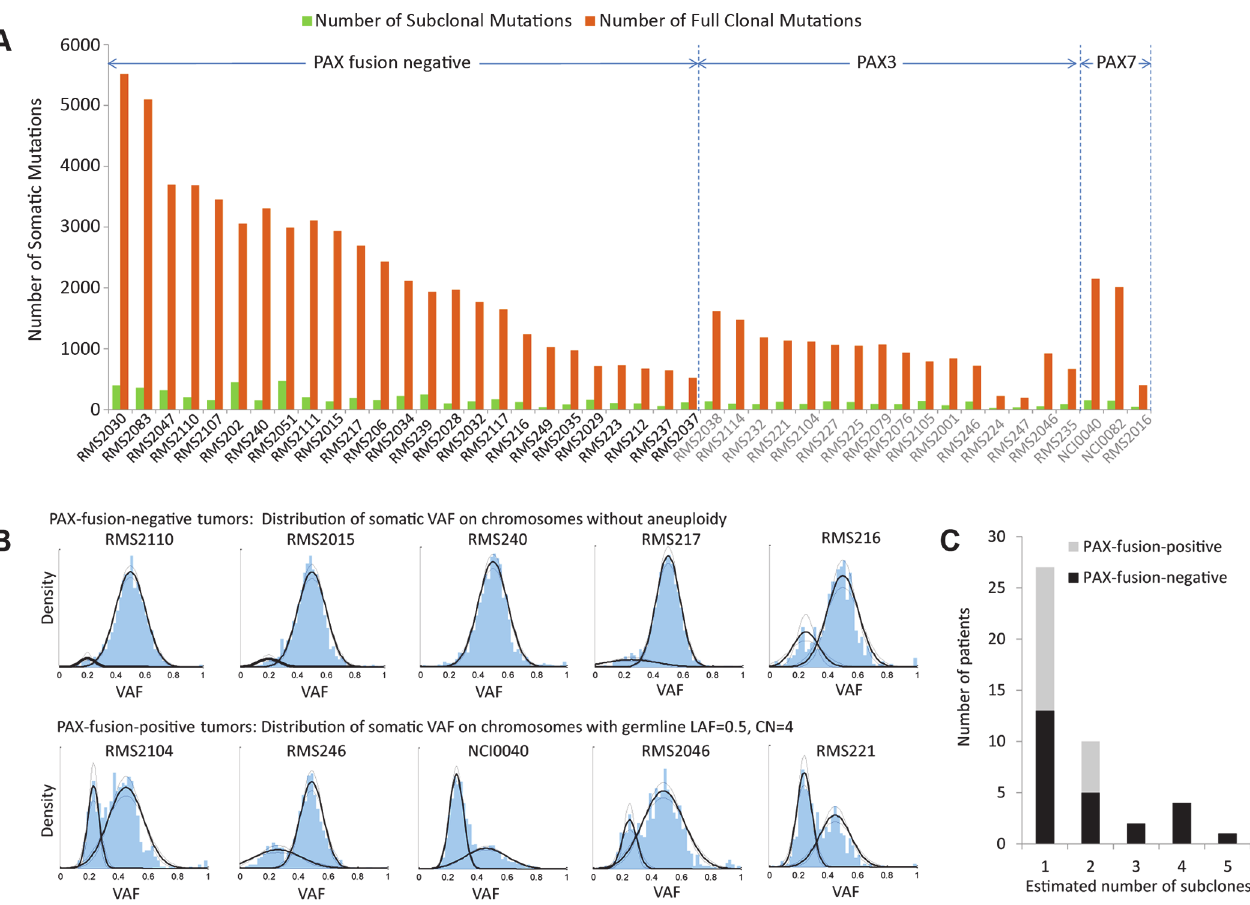
Fig 2. Subclonality in in 44 rhabdomyosarcoma samples. (a) Only a small number of somatic mutations are subclonal while the majority of them were present in all tumor cells. (b) The top panel shows the distribution of VAF of somatic mutations on chromosomes without aneuploidy for selected PFN-RMS samples, where a dominant clone is accompanied with a subclone(s). The lower panel shows the distribution of VAF of somatic mutations for selected PFP-RMS samples. Because these samples have undergone whole-genome duplication, the VAF of somatic mutations on tetraploid chromosomes is distributed around 0.5 and 0.25. (c) PFN samples have more detectable subclonal copy number alterations than PFP samples (p = 0.05, from Mann-Whitney test). It is possible that there are additional subclones that possess subclonal mutations or copy number alterations undetectable with our sequencing depth.